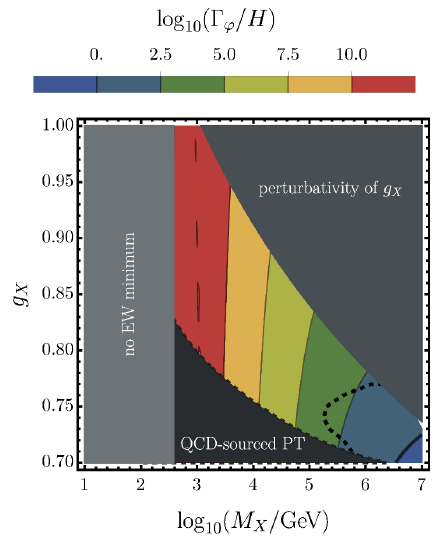
Figure 8 . Contour plot of the decimal logarithm of the ratio of the energy transfer rate Γ ϕ to the Hubble parameter H . The equality H = Γ is indicated as thick black solid line in the lower ϕ right corner. The percolation bound is shown as black dashed line (in other plots it is show as a light-grey